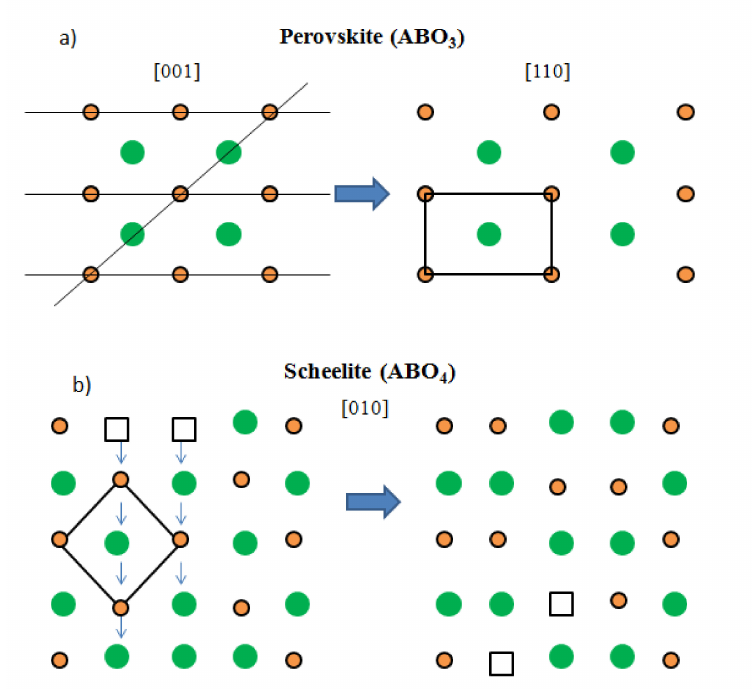
Figure 6. Topotactic transformation from the ( a ) perovskite structure to the ( b ) scheelite structure at 600 ◦ C. The large green spheres represent Sr atoms; small red circles are Mo atoms; squares represent Sr vacancies. The shift of double rows of Sr atoms via vacancies accounts for the transformation of the metal substructures. The rearrangement of oxygen atoms is detailed in Figure